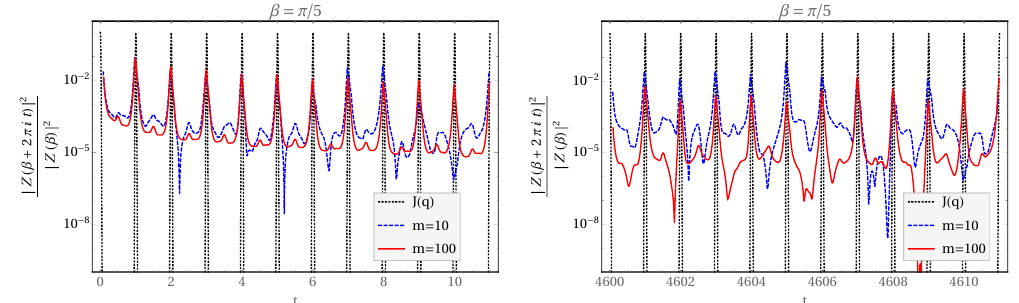
Figure 1 . Left: SFF’s at continuous, early t , of di(cid:11)erent models. Right: SFF’s at continuous, late t , of the same models. By eye one can see that the behavior is more irregular at late times. The dotted spikes are from the J -invariant, which is strictly periodic with period equal to the mini-recurrence time. The dashed and solid curves are from m = 10 and m = 100 minimal models